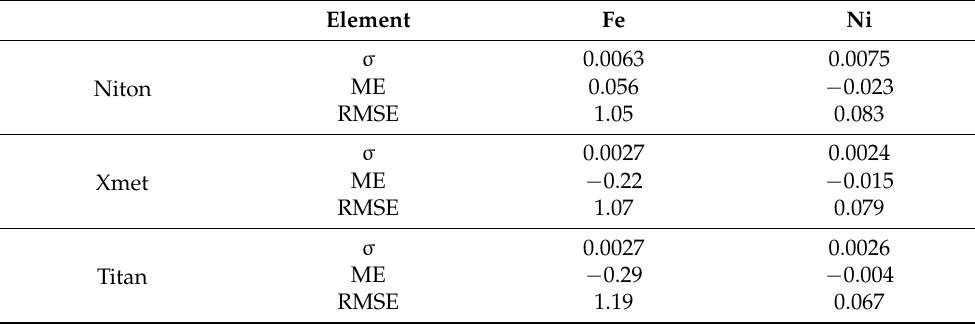
Table 5. Parameters of correction by Beer-Lambert law proposed by Ge and coauthors [16] for the two elements and for the three devices ( σ : Attenuation coefficient, ME: Mean error, RMSE: Root-mean-square error). Element Fe